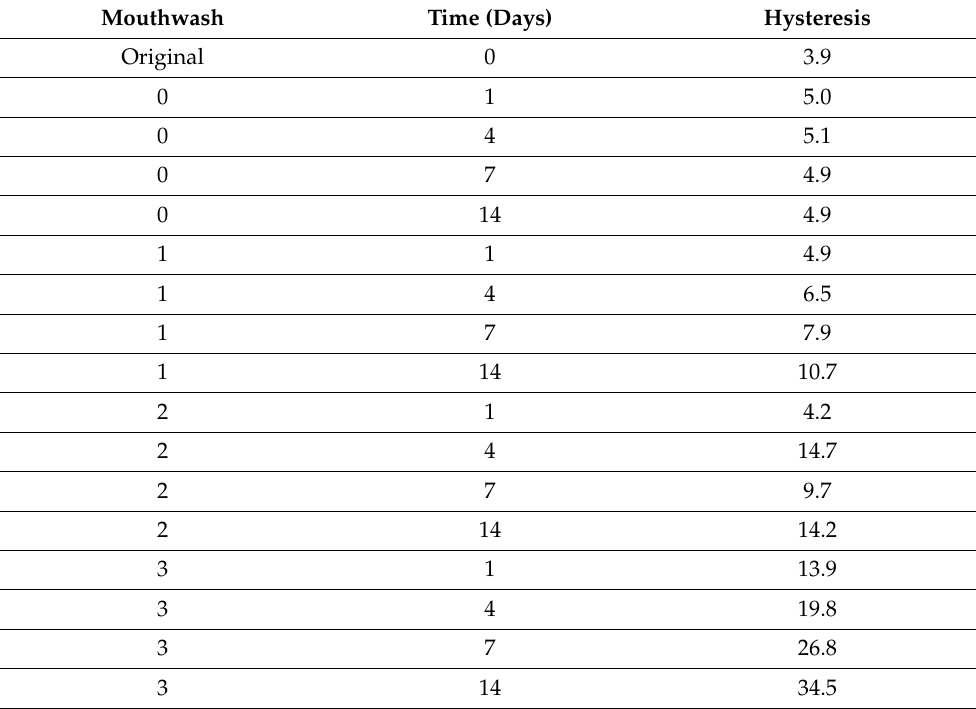
Table 5. Thermal hysteresis of the NiTi treated with different mouthwashes at different times. Mouthwash Time (Days) Hysteresis